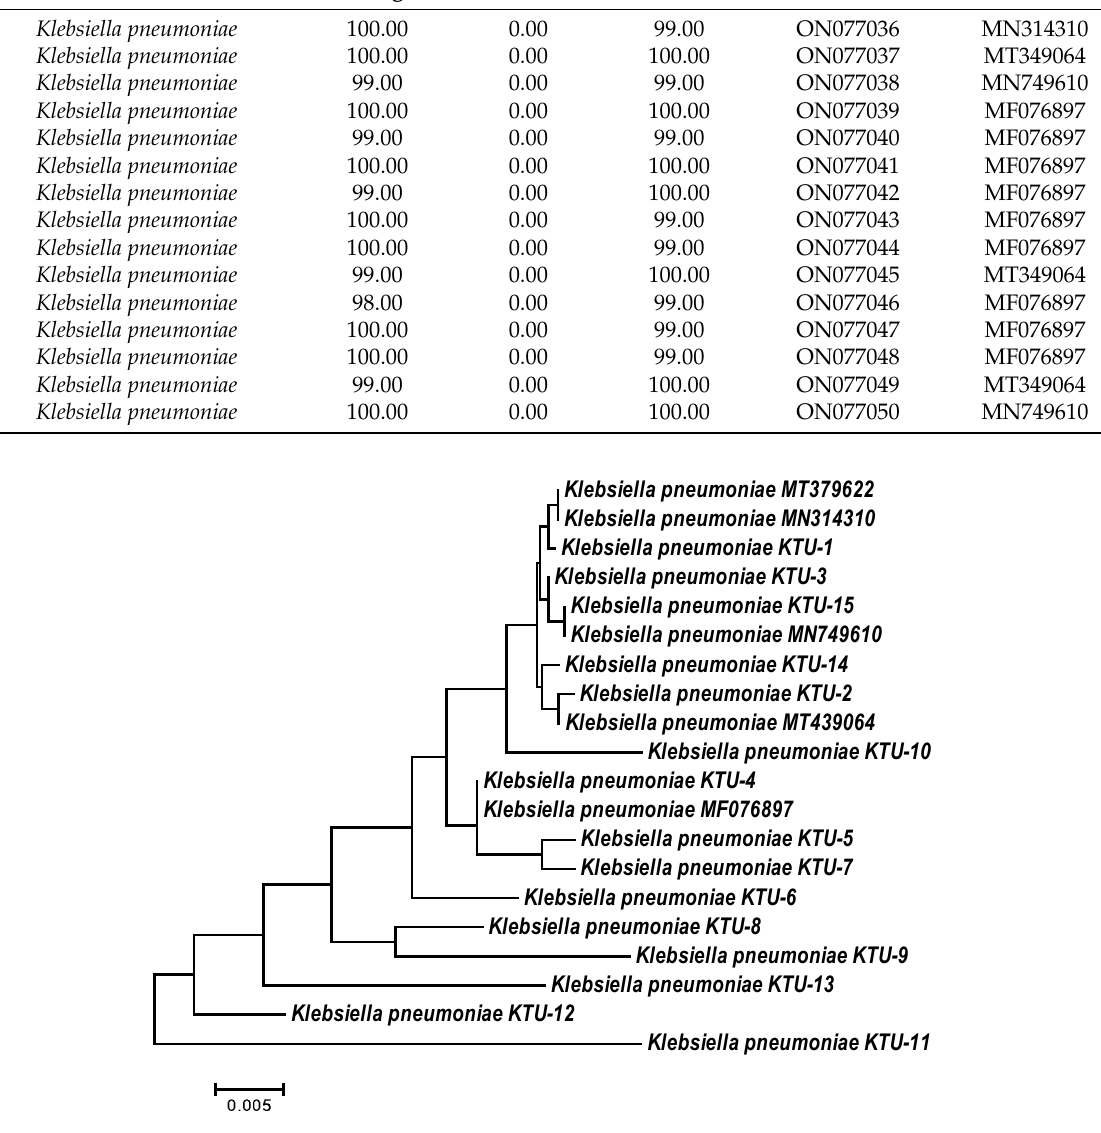
Figure 1. Neighbor-joining phylogeny tree based on 16S rDNA gene sequences of Klebsiella pneumoniae isolates collected from some invertebrates in Taif, Saudi Arabia, with 1000 bootstraps.